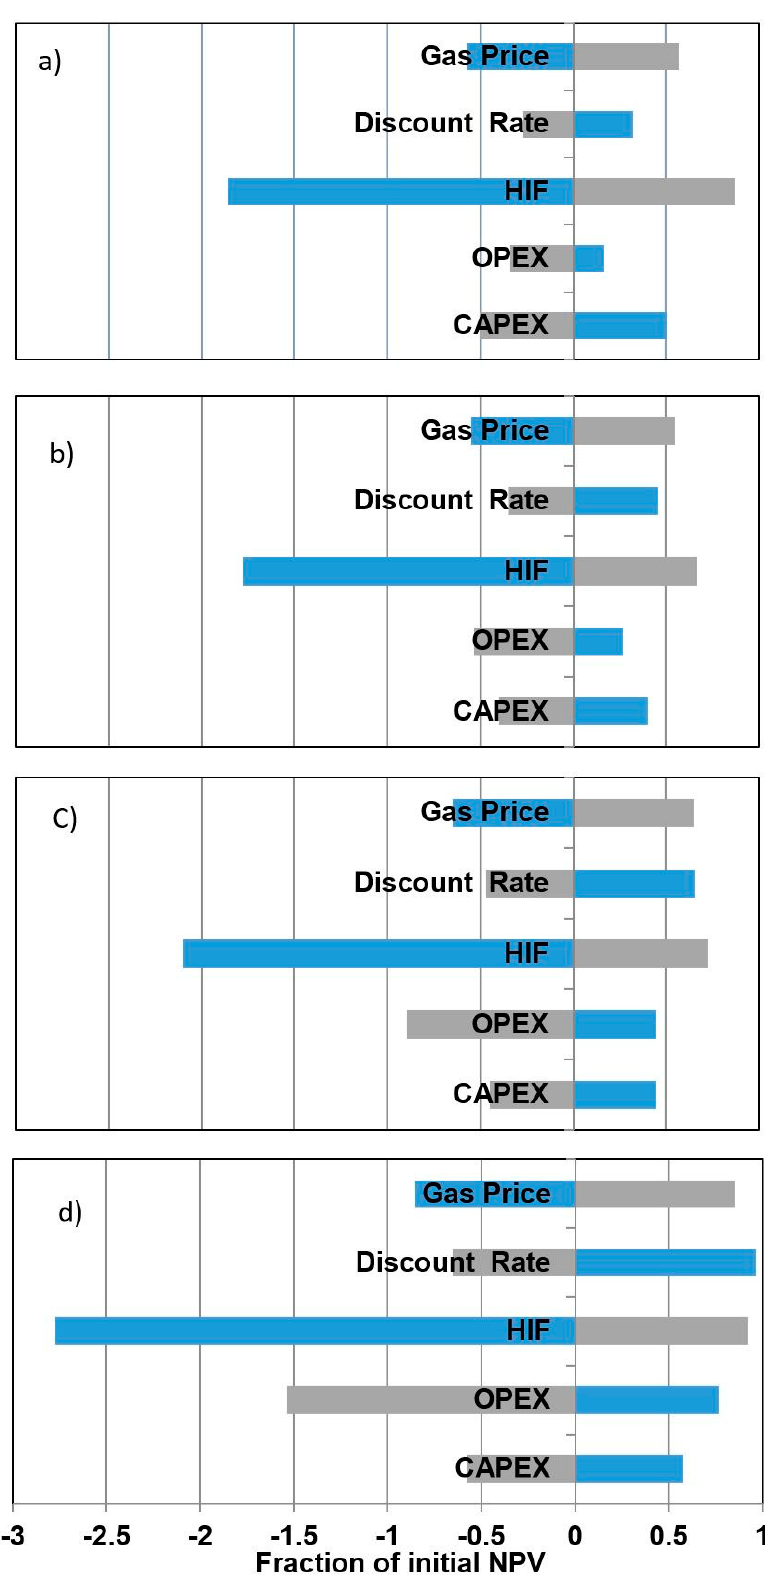
Figure 2. Variation of net present value (NPV) over time for change in different economic parameters and HIF. ( a ) End of the 5th year of production; ( b ) End of the 10th year of production; ( c ) End of the 15th year of production; ( d ) End of the 20th year of production.